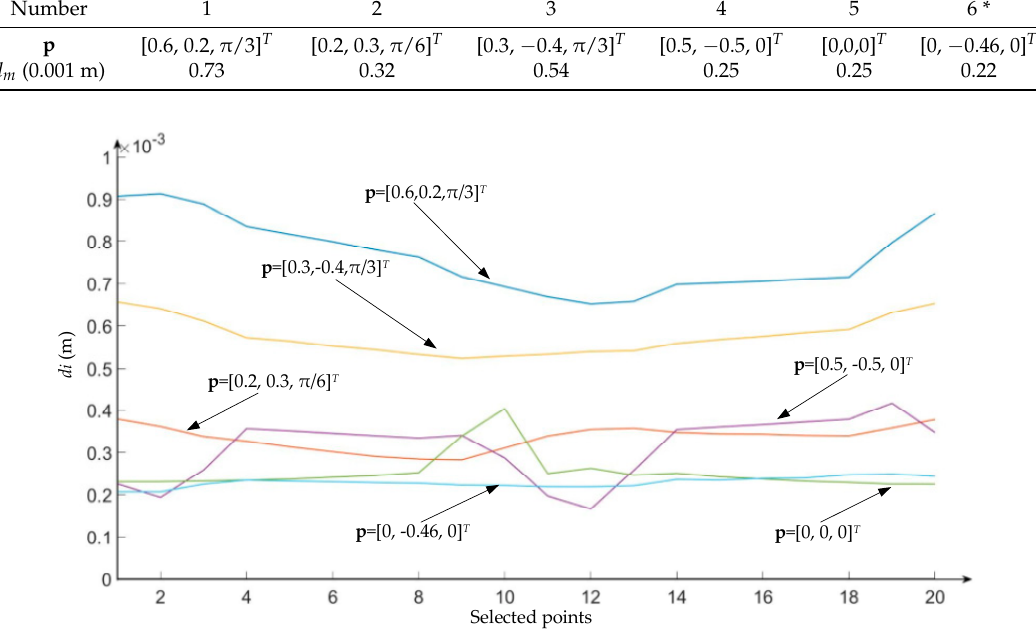
Figure 8. d i with different workpiece poses along the milling groove.